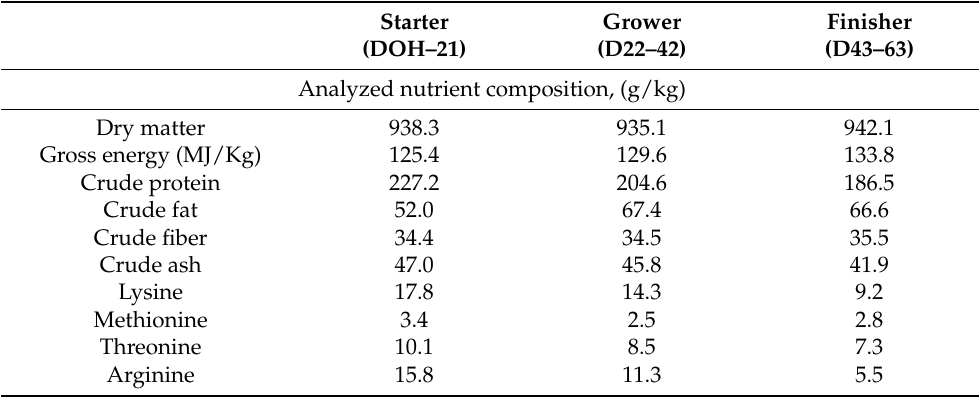
Table 1. Nutrient composition of the basal